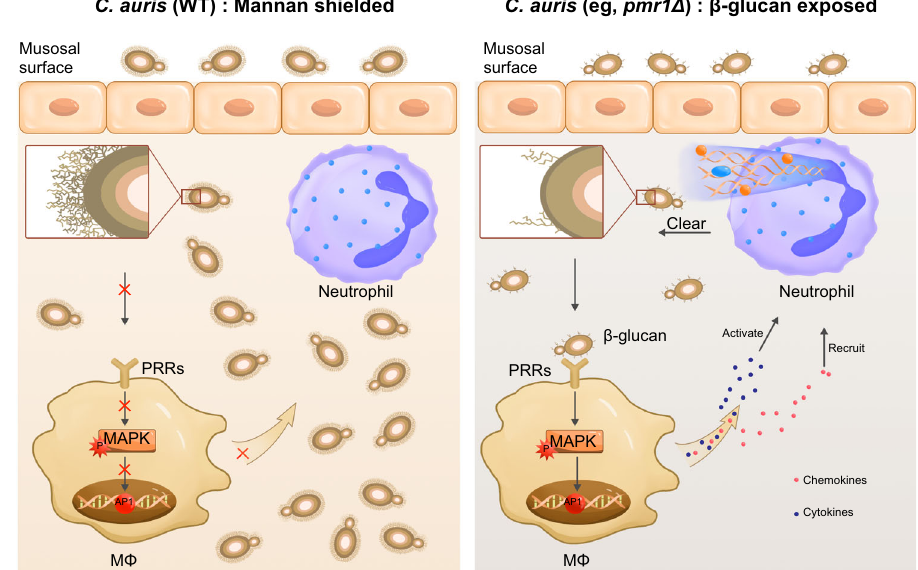
Fig. 7 Proposed model for the role of C. auris outer mannan layer in dampening innate immune responses. C. auris has a structurally distinct mannan layer at the cell wall surface that shields the inner β -glucan, reducing recognition by the receptors of innate immune cells such as macrophages. Reduced macrophage activation leads to successful colonization and proliferation of C. auris by avoiding being cleared by immune cells such as neutrophils. In contrast, the disrupted mannan layer in C. auris leads to exposure to β -glucan, which can be recognized by the surface receptors of macrophages. The host- pathogen interaction results in the activation of MAPK signaling pathway and release of pro-in fl ammatory cytokines and chemokines, which fi nally leads to activation and recruitment of neutrophils and triggers the clearance of invading C. auris . Note: Inset represents an enlarged area of the three layers of C. auris cell wall, which is organized in an inner skeletal layer comprising chitin, β -glucan, and an outermost layer dominated by highly glycosylated